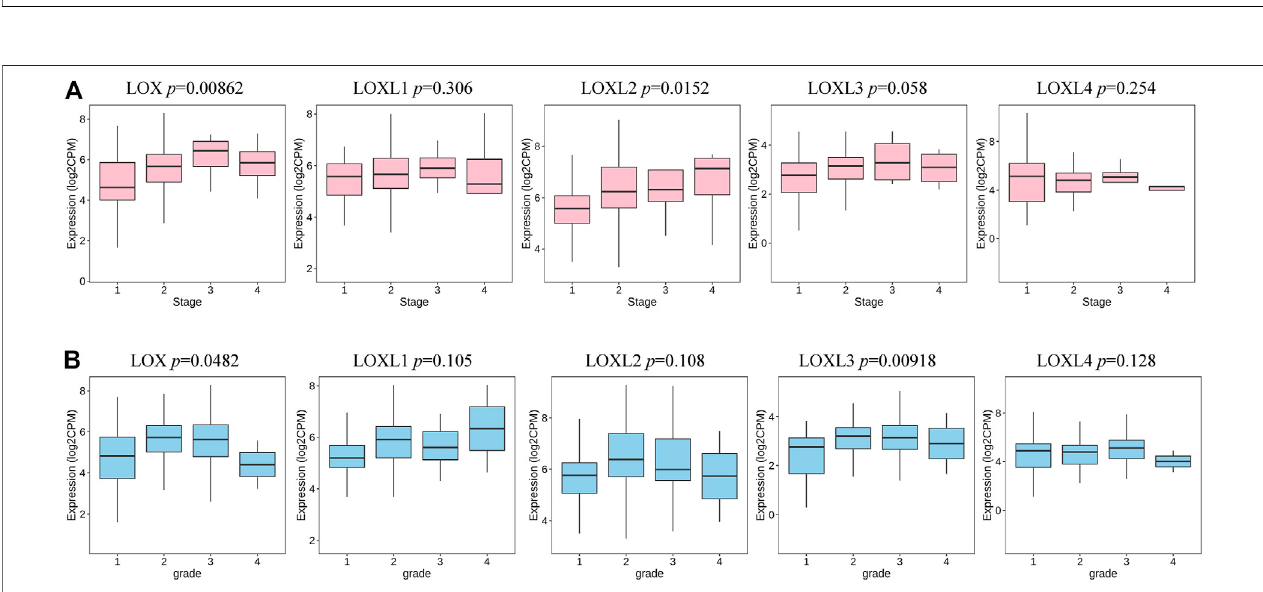
FIGURE5| TranscriptionlevelsofLOXsindifferentstagesandgradesofpatientswithPDAC(TISIDB). (A) TheexpressionofLOXandLOXL2washighlycorrelated to the stage of the PDAC. (B) The expression of LOX and LOXL3 was signi fi cantly associated with tumor grade in PDAC.